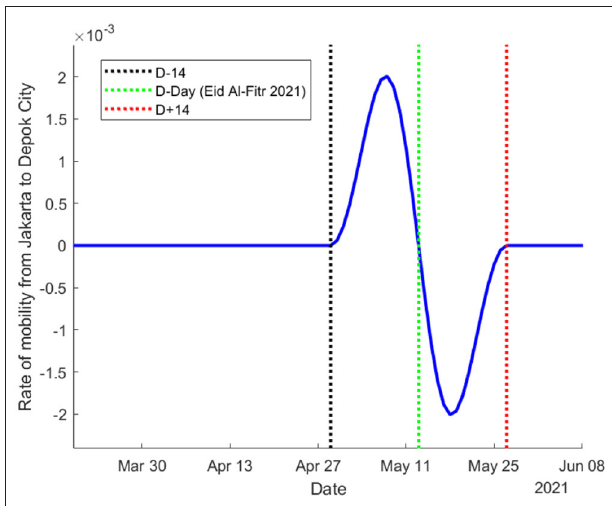
FIGURE 5 | The estimated dynamics of mobility rate from Jakarta to Depok City, ranging from mid of March until late June 2021.